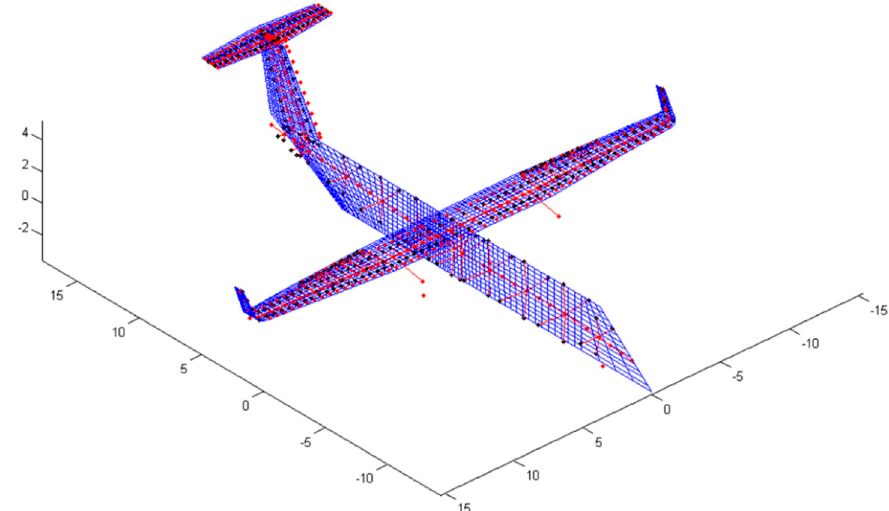
Figure 1. Aeroelastic model of a regional aircraft equipped with morphing winglets; aerodynamic lattice (blue), structural model elements and grids (red).